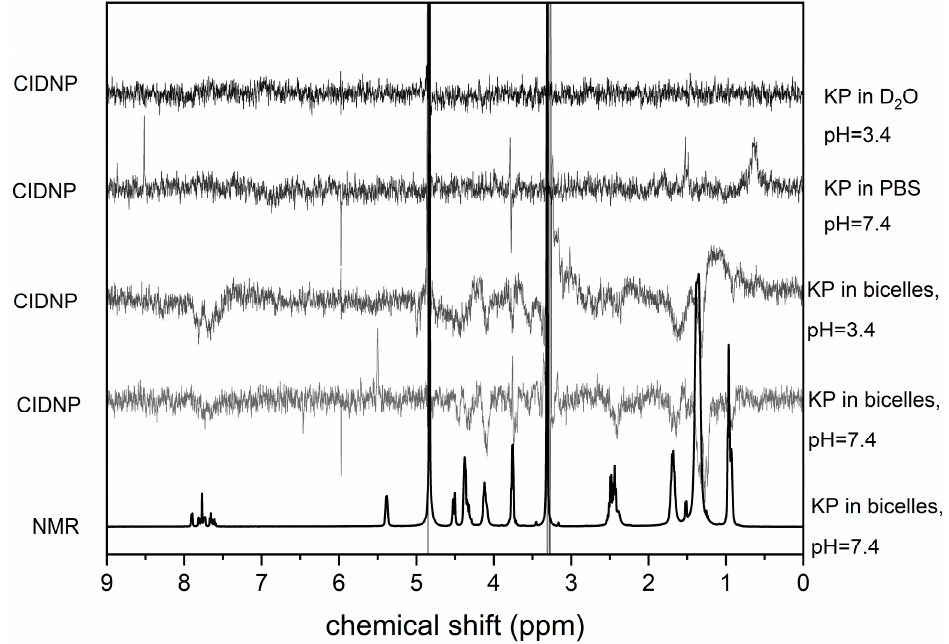
Figure 7. 1 H NMR and CIDNP spectra of KP in water solution and DHPC/DMPC bicelles at different pH of the media.